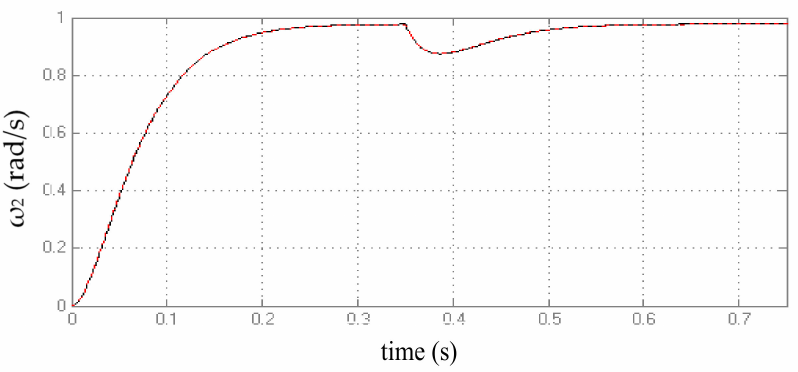
Figure 11. Transient characteristics and reaction of the system when the load moment changes at t = 0.35 s, by using feedback coefficients synthesized based on: __ traditional model; __ models with a fractional order integral to describe the elastic moment.